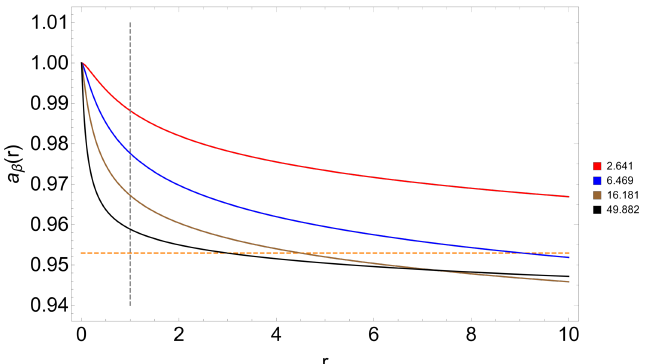
Figure 14. Plot of a β (in the unit of 2 πl − 2 deformation increases (values of A 1 position of the horizon and the horizontal orange line represents a β = 81